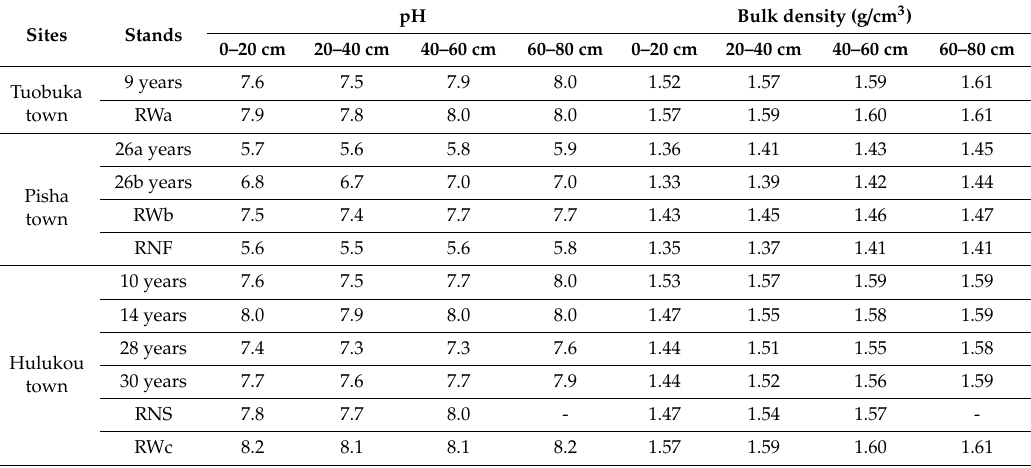
Table 2. Soil parameters, such as pH and soil bulk density, at each